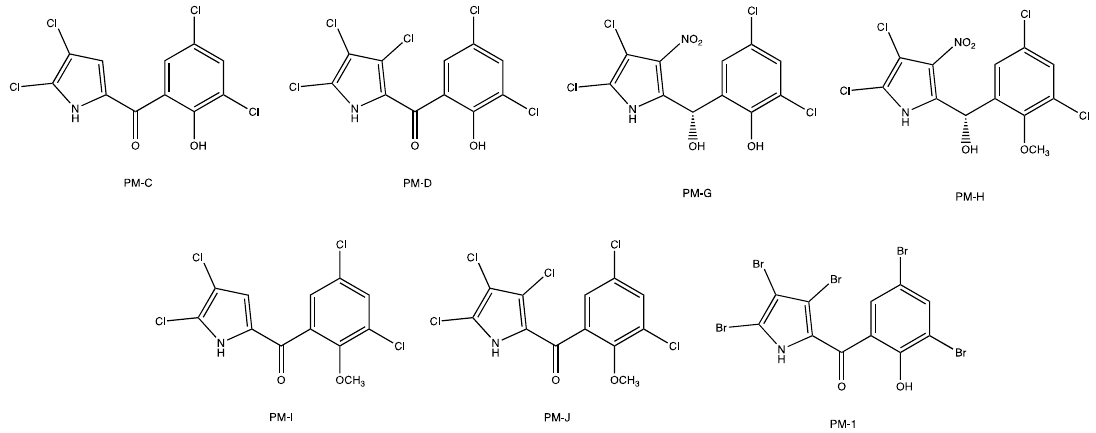
Figure 1. Chemical structure of some natural pyrrolomycins (PMs) and the synthetic one PM 1 .